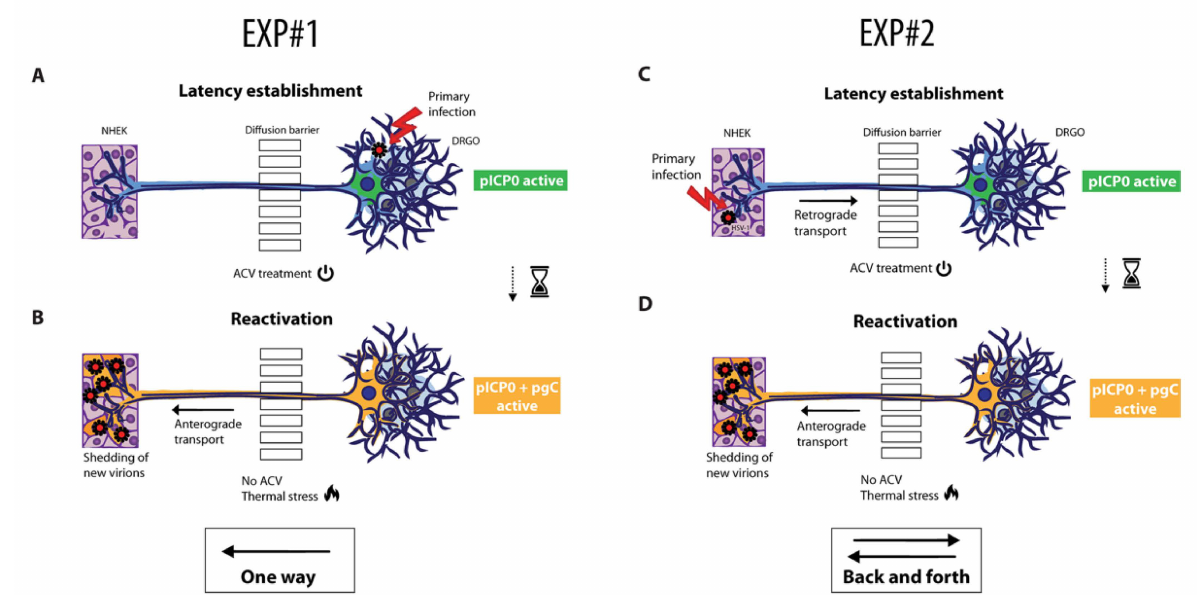
Figure 5. Testing HSV-1 latency in the microfluidic culture system. Graphical representation for HSV-1 latency establishment directly in DRGOs following anterograde virus spread (EXP #1, ( A , B )) or retrograde–anterograde virus spread (EXP #2, ( C , D )). In EXP #1, organoids were infected ( A ) and latency was obtained through ACV addition to the culture medium. Thermal stress ( B ) led to controlled reactivation, and anterograde transport of virus particles resulted in NHEK lytic infection. EXP #2 instead was carried out by HSV-1 latency establishment indirectly in DRGOs ( C ). NHEK cells were infected, and retrograde transport of virus particles resulted in HSV-1 latency establishment in organoids. Then, thermal stress ( D ) led to controlled virus reactivation, and anterograde transport of virus particles resulted in NHEK lytic